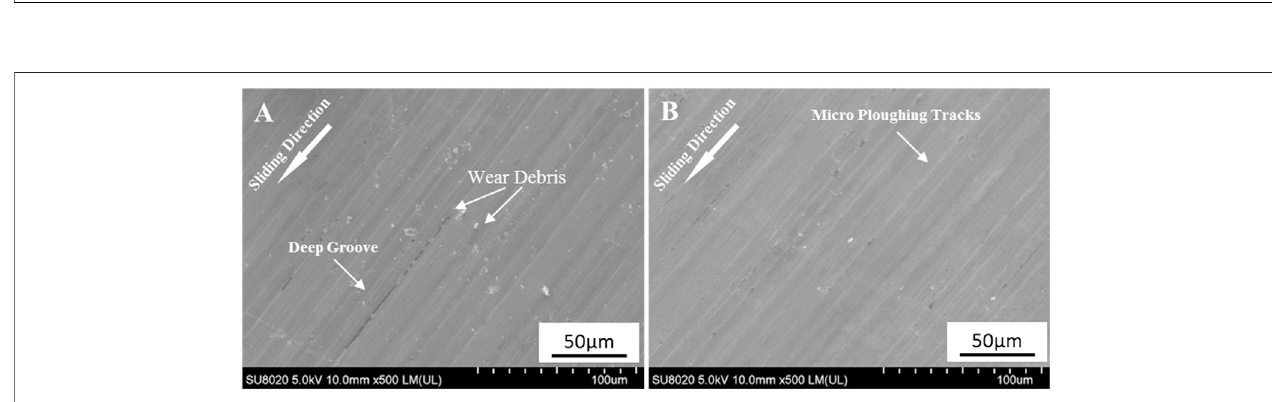
Frontiers in Materials |